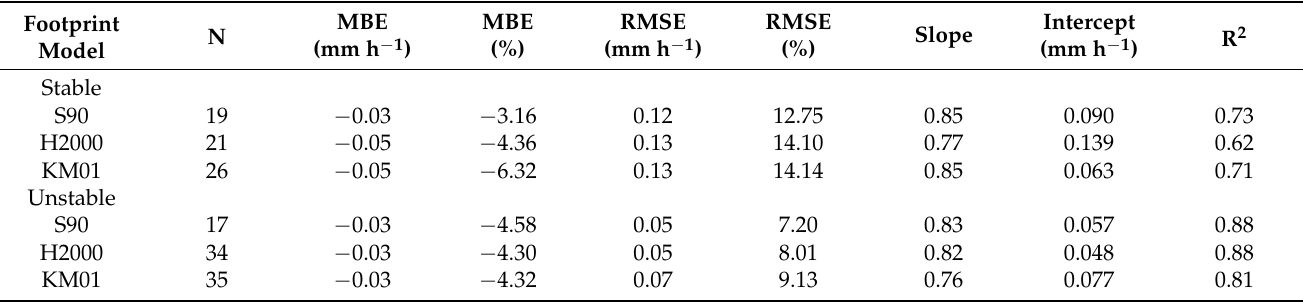
Table 6. Comparison of composite ET calculated using the combination of the lysimeter and EC data to the ET from EC8 for different atmospheric stability regimes. Footprint Model